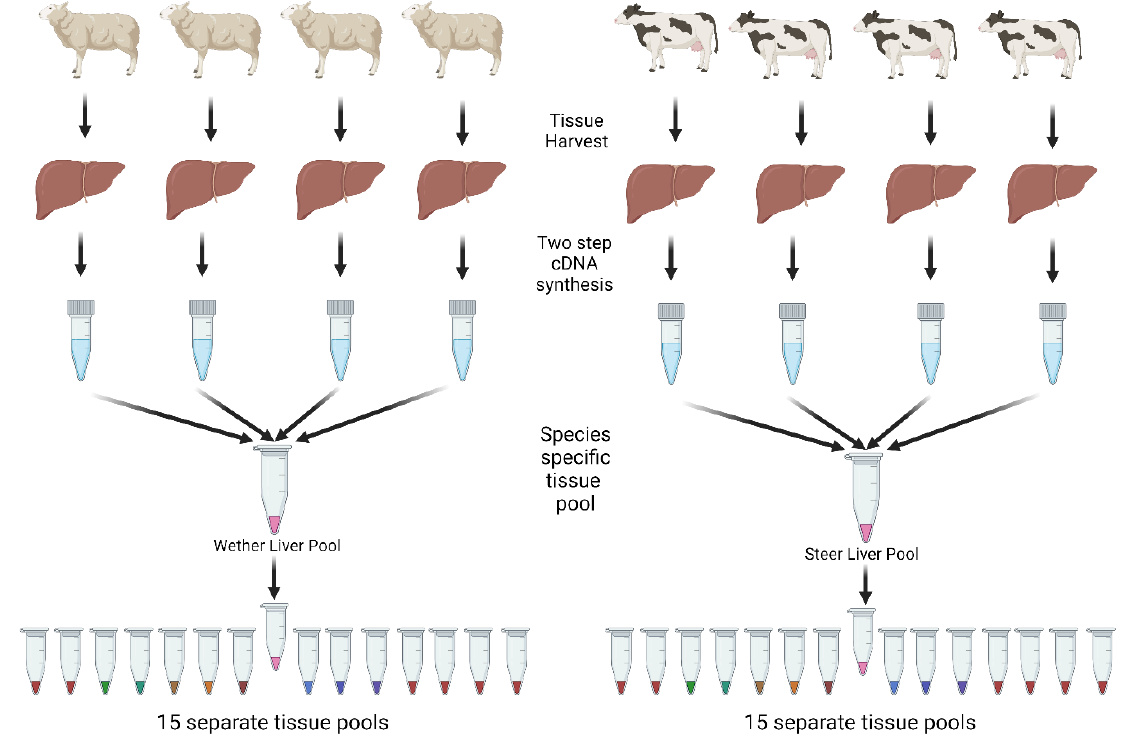
Figure 1. cDNA pooling strategy used for species-specific tissues prior to qPCR screening. A total of 15 tissues were harvested from 4 steers and 4 wethers. RNA was extracted from all tissues and used to create a cDNA library. There was a total of 4 biological replicates for each tissue in both species and these cDNAs were pooled into a single sample for qPCR screening of VIP, VPAC1, VPAC2, PACAP, PAC1, and reference genes.